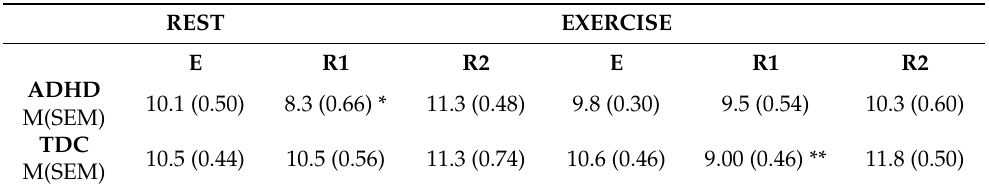
Table 3. Means (M) and standard error of mean (SEM) of correctly recalled word pairs during Encoding (E—afternoon), Retrieval 1 (R1—evening), and Retrieval 2 (R2—morning).